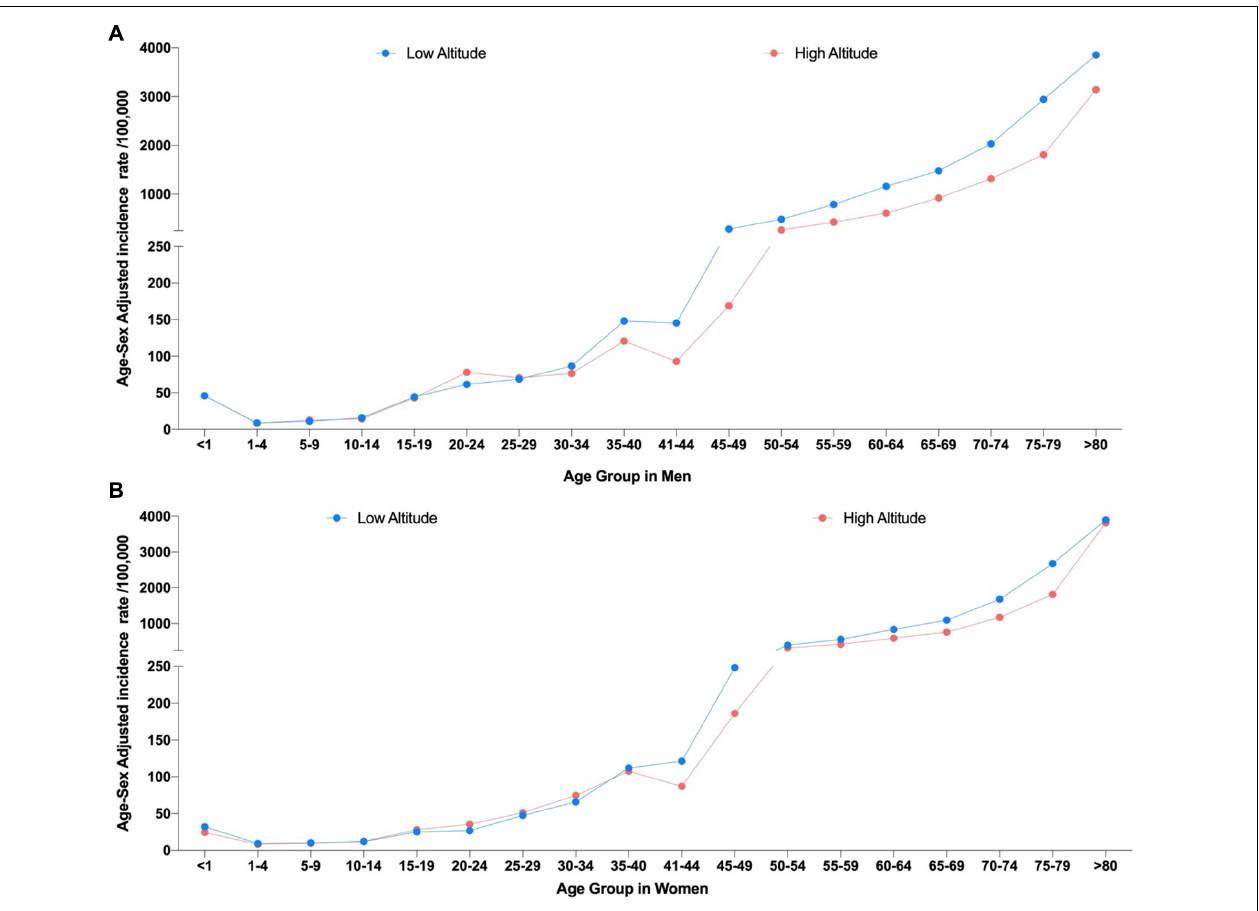
FIGURE 4 | Age-sex adjusted incidence rates due to stroke by age group using the two elevation categories. (A) Incidence rates in men at low altitude ( < 2,500 m) and high altitude ( > 2,500 m) and (B) Incidence rates in women at Low altitude ( < 2,500 m) and High